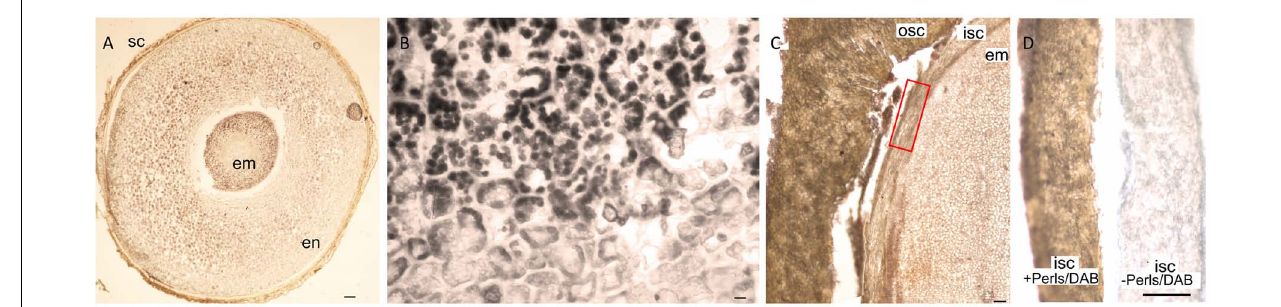
FIGURE 6 | Unusual Fe storage in the endosperm and in the seed coat. Fe staining in Euonymus europaeus and Moringa peregrina. Cross sections were stained with Perls/DAB and observed under light microscope. (A) Euonymus europaeus . (B) A close-up to endosperm tissue of Euonymus europaeus . (C) Moringa peregrina , focused on a small part of the seed. Embryo, inner and outer sections of the seed coats are visible. Moringa peregrina does not possess an endosperm and has a thick two-layered seed coat. (D) Dissected inner seed coats of Moringa peregrina. Left, Perls/DAB stained, right unstained control. Fe staining appeared brown in panels (A,C,D) and black in panel (B) . Seed coat in panel (A) and outer seed coat in panel (C) were already brown before the staining, thus the color does not reflect the stained Fe. In contrast, inner seed coat of Moringa peregrina is white, and brown color in panel (C) shows the stained Fe. sc, seed coat; en, endosperm; osc, outer seed coat; isc, inner seed coat; em, embryo. Bar is 0.1 mm for panel (A) , 0.01 mm for panel (B) , 1mm for panels (C,D) .